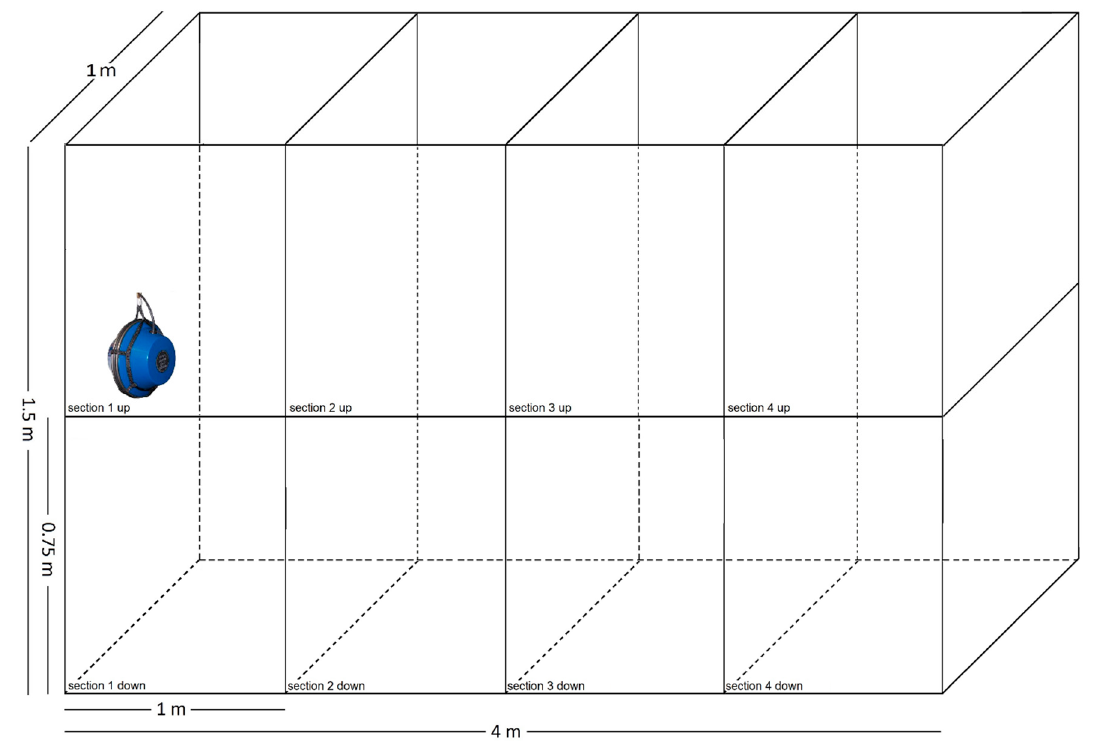
Figure 3. Subdivisions of the aquarium in cells and sectors. Section Up, constituted by 1, 2, 3, and 4 up cells. Section Down, constituted by 1, 2, 3, and 4 down cells. Section Left, constituted by 1–2 up and 1–2 down cells. Section Right, constituted by 3–4 up and 3–4 down cells. On the left wall, the location of the underwater sound speaker is presented.